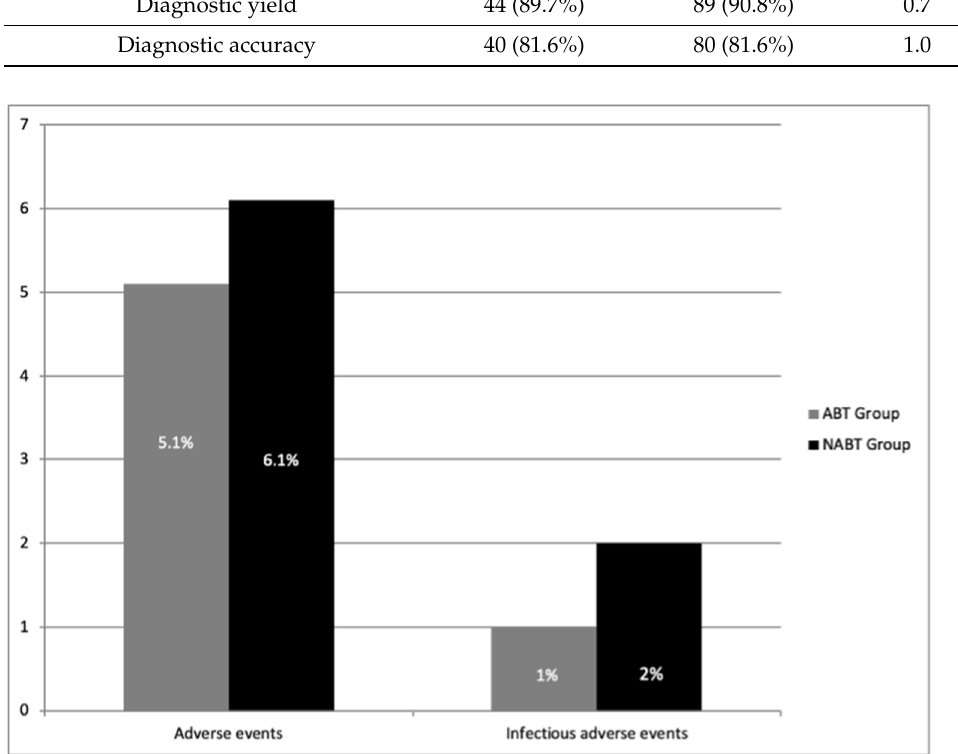
Table 2. Outcomes. Outcome